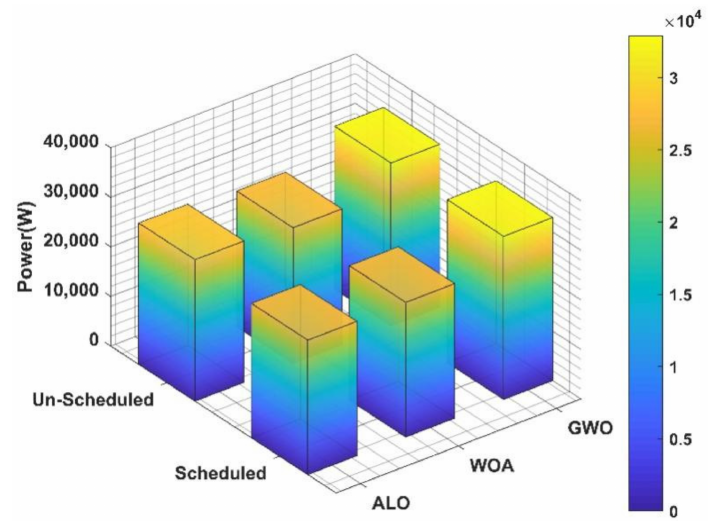
Figure 10. Comparison of ALO, GWO, and WOA for input